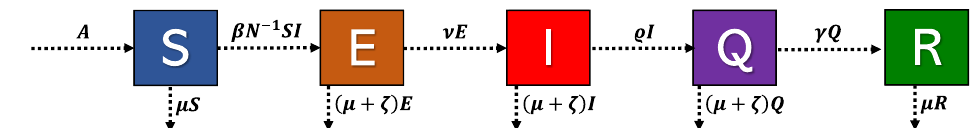
Fig. 2. A modi fi ed SEIR transmission model in which the boxes and the arrows represent the different compartments and transition rates used